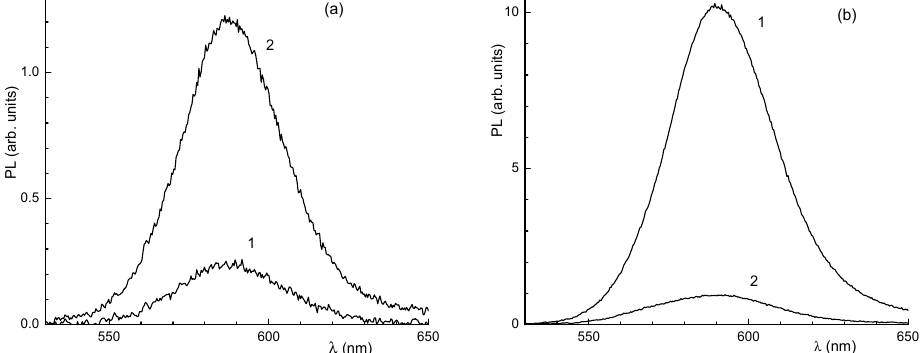
Figure 9. Photoluminescence spectra of sols of nanocomposites (2.5 mg/mL) in toluene based on CdSe QDs: ( a ): M1 (1) and M2 (2); ( b ): T1 (1) and T2 (2).